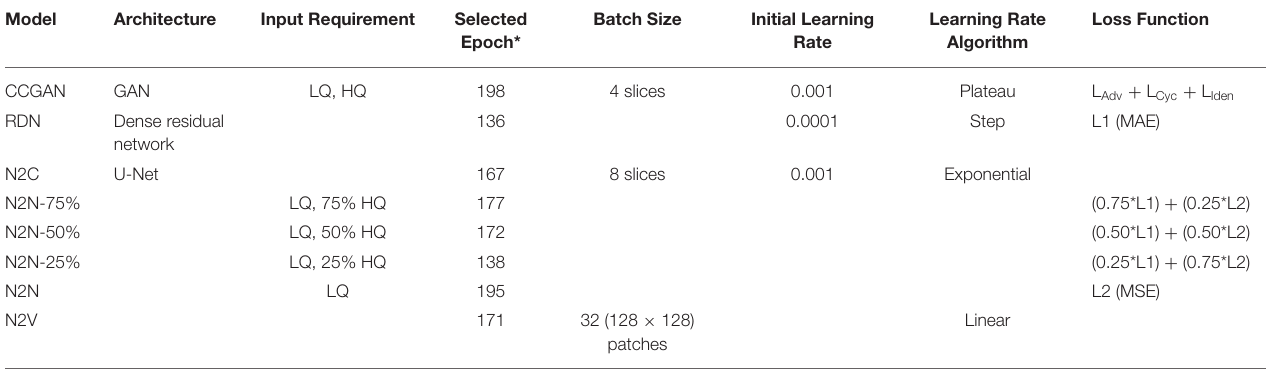
TABLE 4 | Parameters selected for the DL-based denoising algorithms used in this study. Model